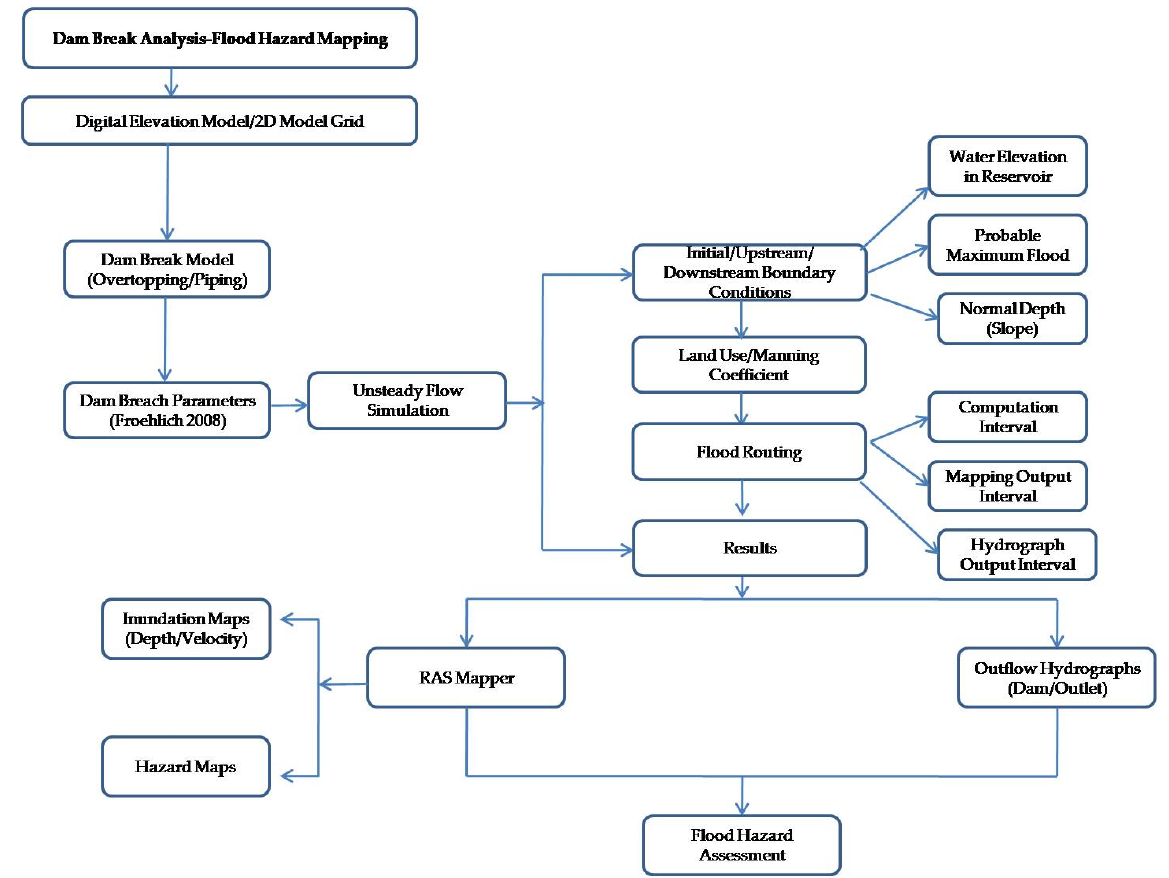
Figure 4. Methodological approach of the Papadia dam breach analysis.